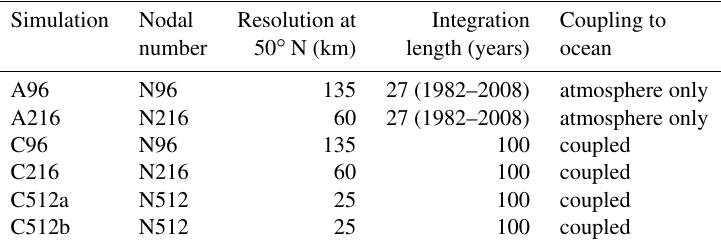
Table 1. The resolution, integration length, and type of ocean coupling are listed for all simulations. All simulations have 85 vertical levels with a model lid at 85km. Simulation Nodal Resolution at Integration Coupling to number 50 ◦ N (km) length (years) ocean A96 N96 135 27 (1982–2008) atmosphere only A216 N216 60 27 (1982–2008) atmosphere only C96 N96 135 100 coupled C216 N216 60 100 coupled C512a N512 25 100 coupled C512b N512 25 100